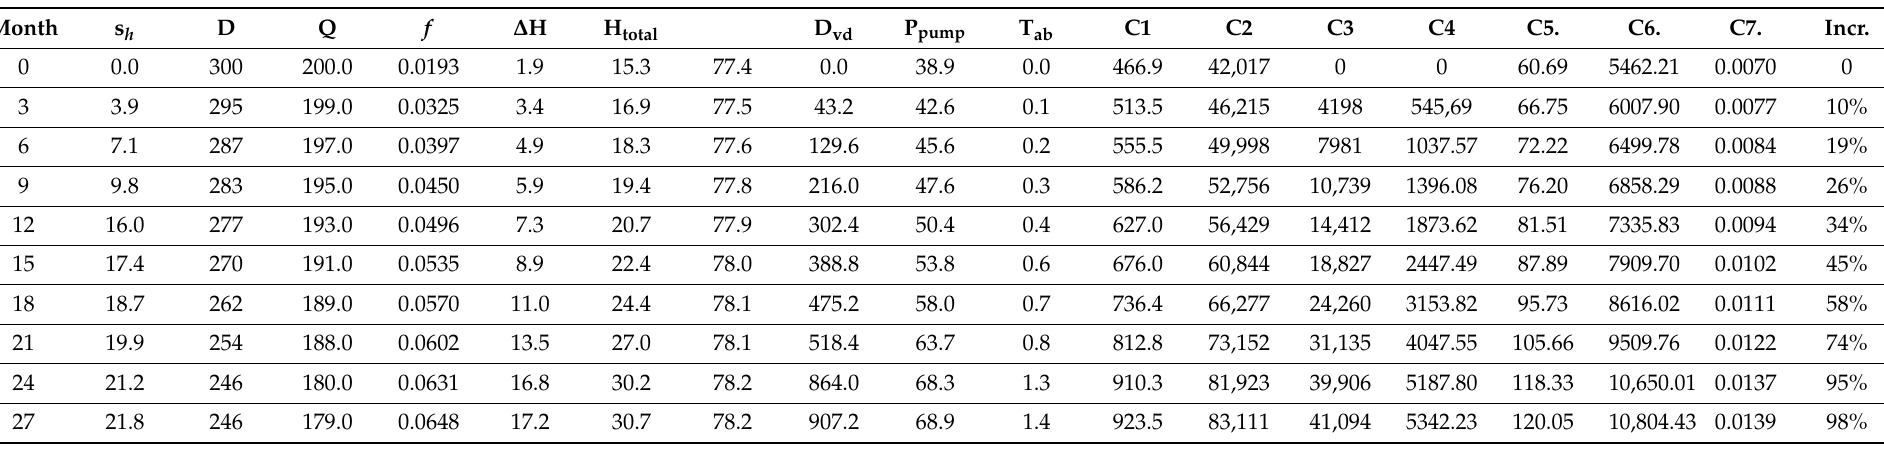
Table 6. Progression of consumption and costs, in view of the progression of GM bioinfestation for Pump 3, with a flow rate of 200 L/s and a diameter of 300